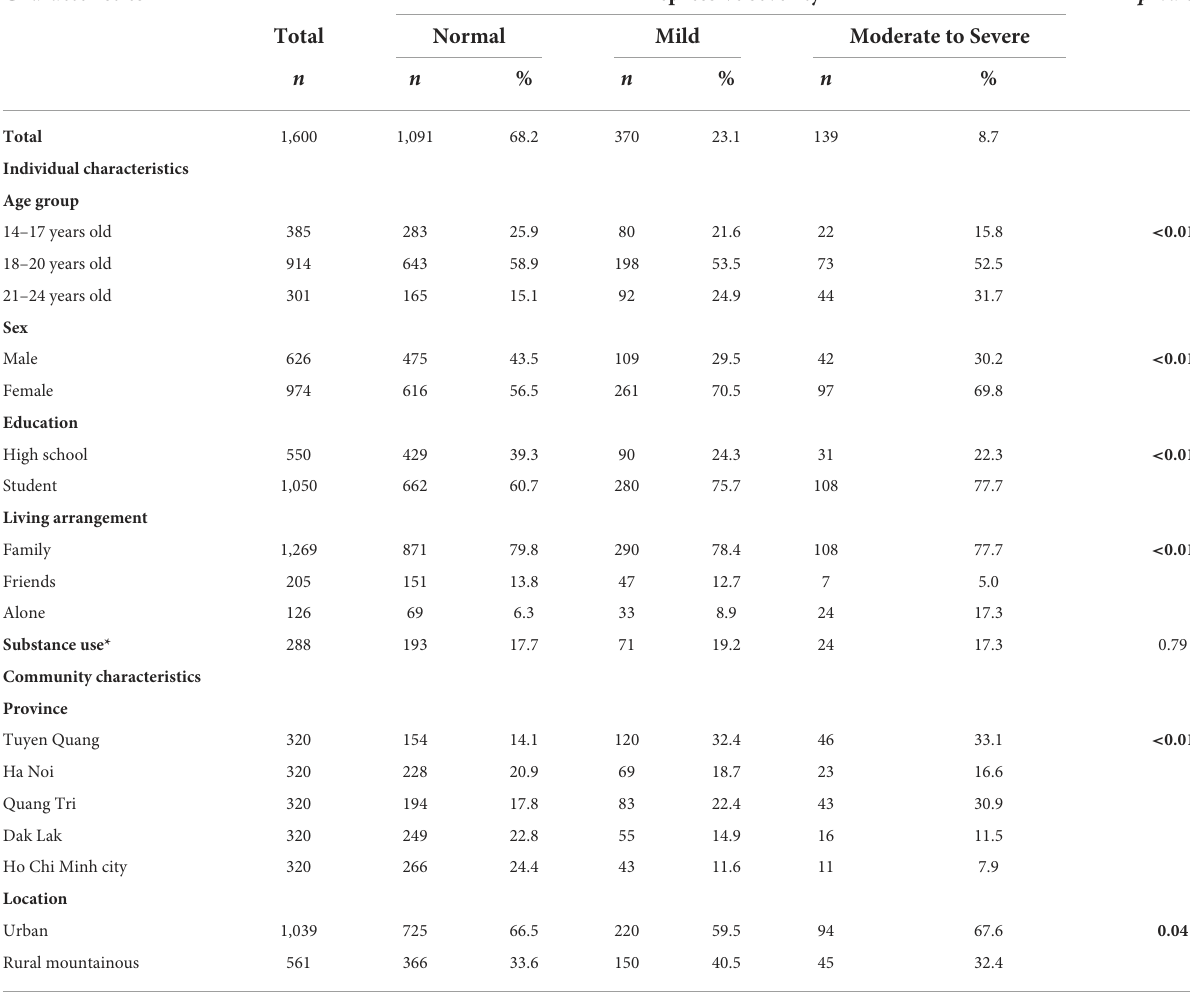
TABLE 1 Sociodemographic and community characteristics.